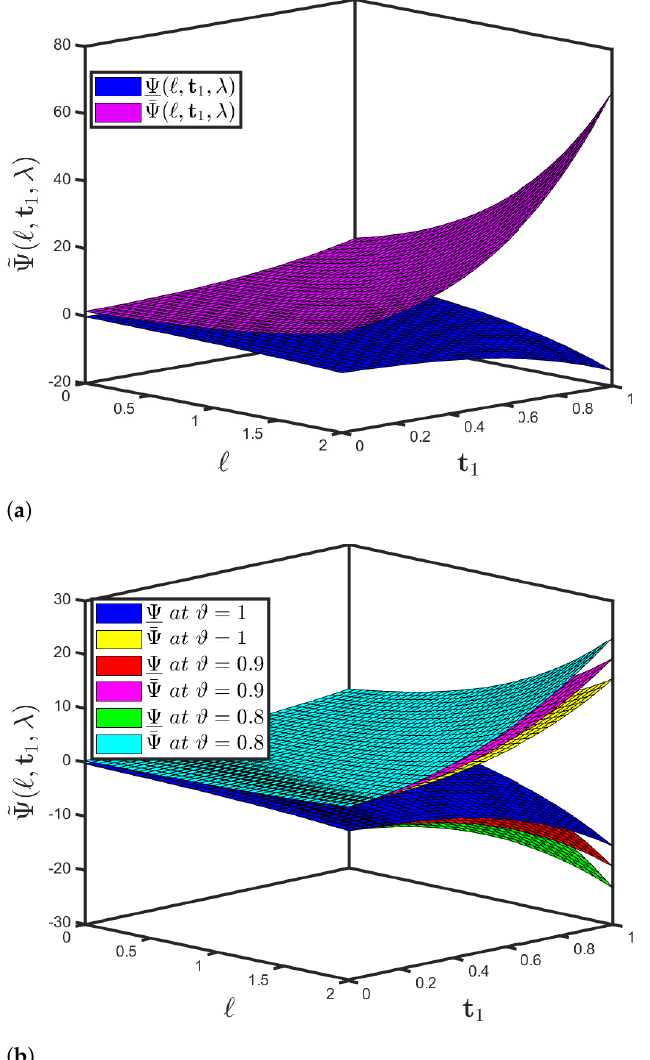
Figure 9. ( a ) Three-dimensional plot of ˜ Ψ ( (cid:96) , t 1 ; λ ) of Problem (3): ( a ) Ψ ( (cid:96) , t 1 ; λ ) and ¯ Ψ ( (cid:96) , t 1 ; λ ) when ϑ = 1; and ( b ) Ψ ( (cid:96) , t 1 ; λ ) and ¯ Ψ ( (cid:96) , t 1 ; λ ) when the uncertainty parameter λ ∈ [ 0,1 ] has different fractional